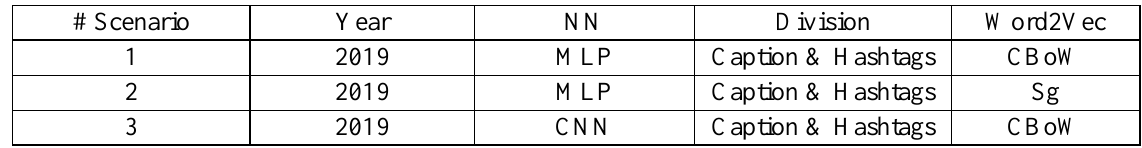
Table 2 Results of analysis